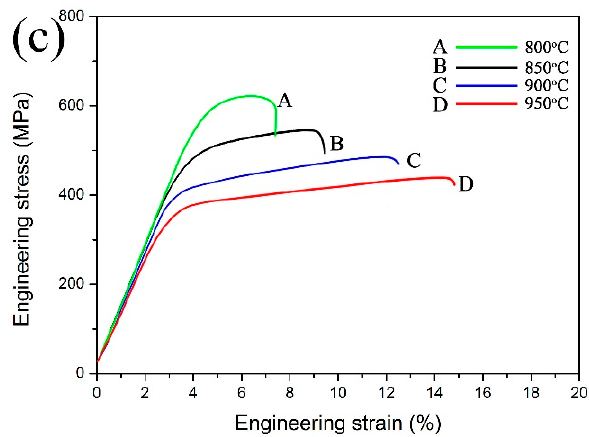
Figure 6. The changes of microhardness ( a ), yield strength and compressive strength ( b ) of composites with the sintering temperature; ( c ) engineering stress–strain curves of composites.